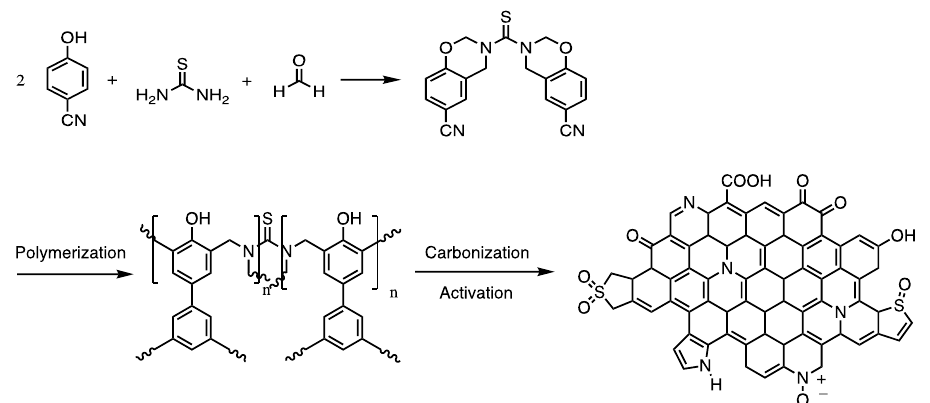
Figure 47. Synthesis scheme for N,S functionalities in the porous carbons (reproduced from the work in [112] with permission).